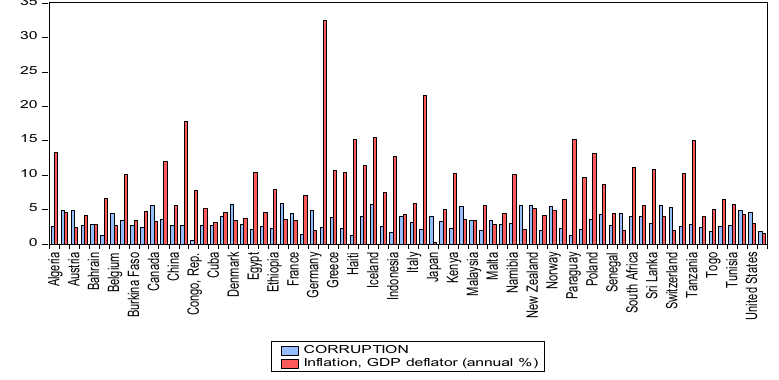
Figure 1. The cross-country relationship of corruption – in fl ation